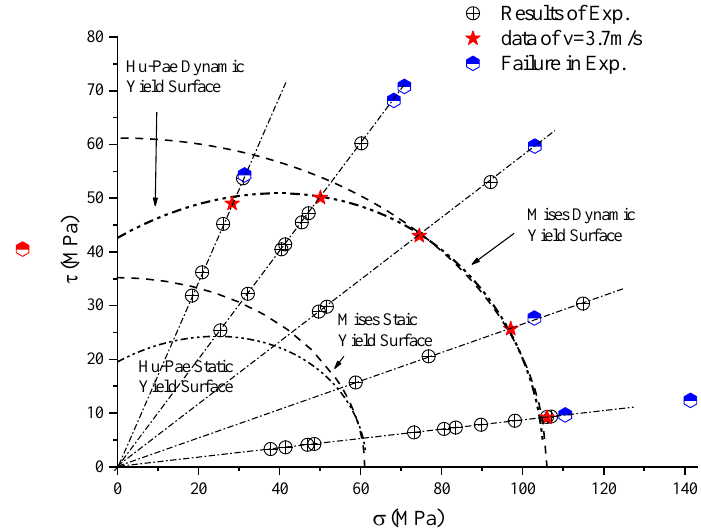
Figure 14. Loading path and evolution of yield surface.